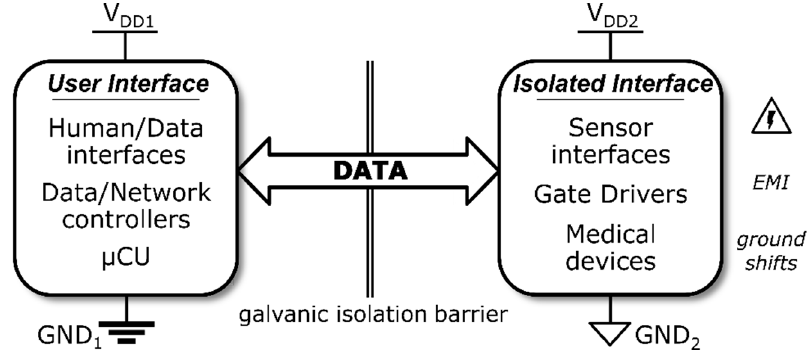
Figure 1. Simplified block diagram of a galvanically isolated system.